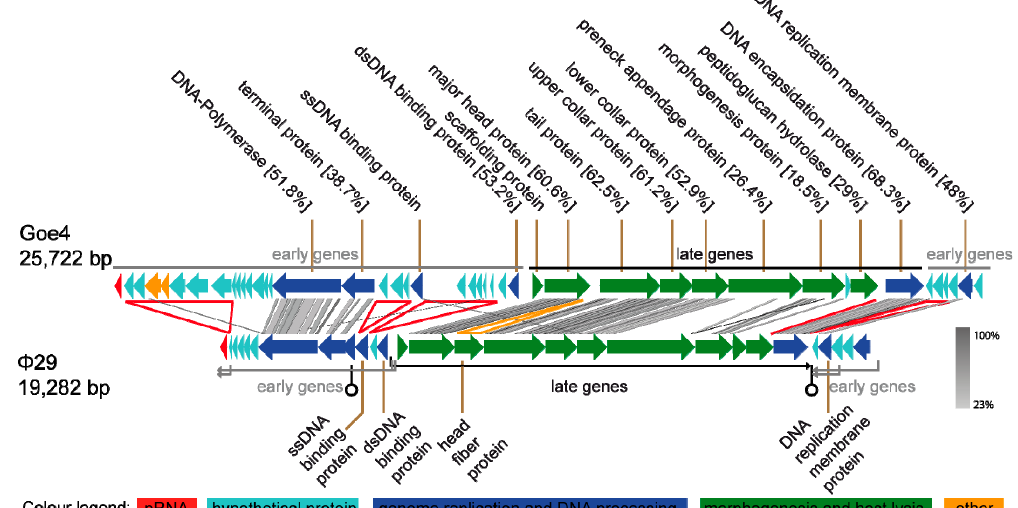
Figure 2. Overview of the Goe4 genome in Relation to φ 29. Similarity indicated by grey bars was calculated via tblastx. Protein coding open reading frames (ORFs) were further compared to the genus type strain φ 29 via global protein alignment employing the Needleman–Wunsch algorithm. The yellow arrowhead indicates a region of φ 29 absent in Goe4 and red arrowheads and line regions of Goe4 absent in φ 29.